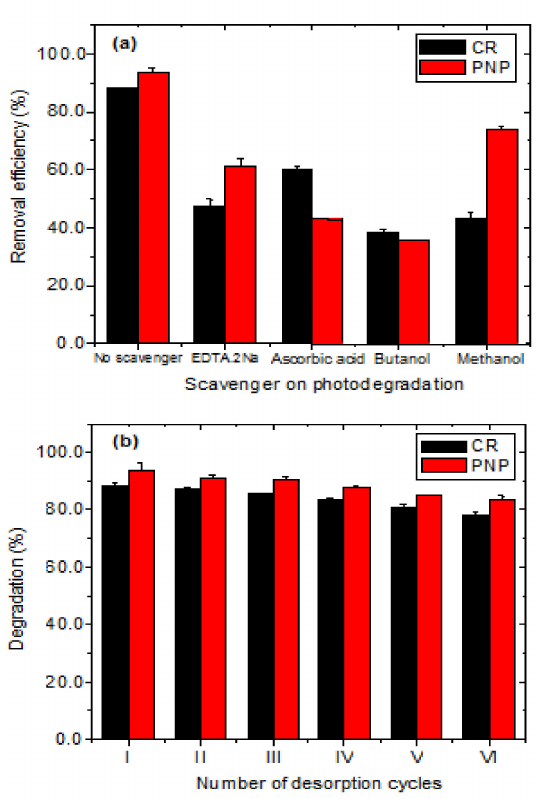
Figure 12. ( a ) Effects of scavengers on photodegradation of CR and PNP. ( b ) Removal of CR vs. desorption cycle. (Experimental conditions: pH, 3.0; temperature, 25.0 ± 1 ◦ C; adsorption time, 2.0 h; adsorbent dose, 0.1 g) and removal of PNP vs. desorption cycle. (Experimental conditions: pH, 3.0; temperature, 25.0 ± 1 ◦ C; adsorption time, 2.0 h; adsorbent dose, 0.01